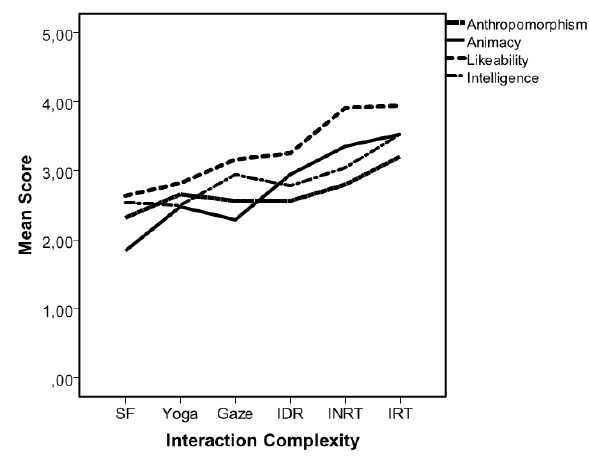
Figure 8: Illustration of the mean scores of each interaction sce- nario in terms of anthropomorphism, animacy, likeability and per- ceived intelligence. Taken from